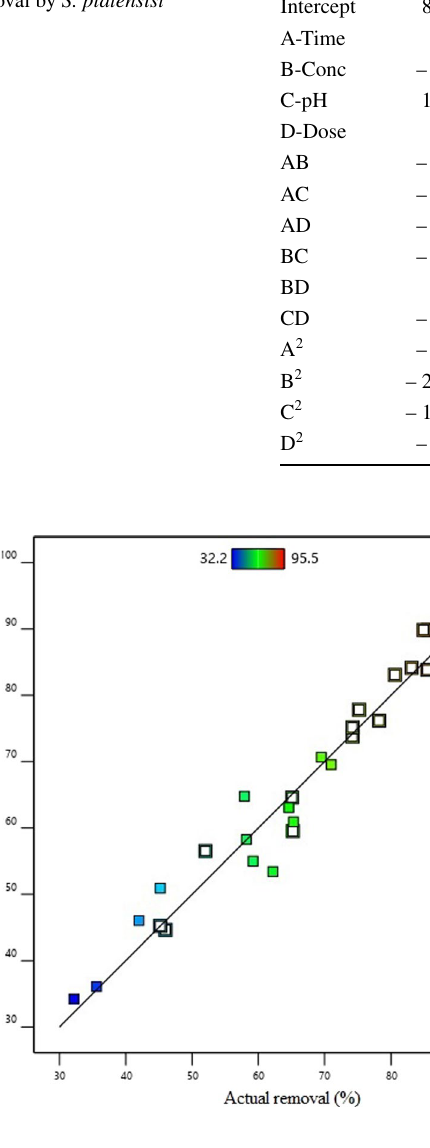
Fig. 5 Distribution of experimental vs. predicted removal for MG adsorption onto S. platensis